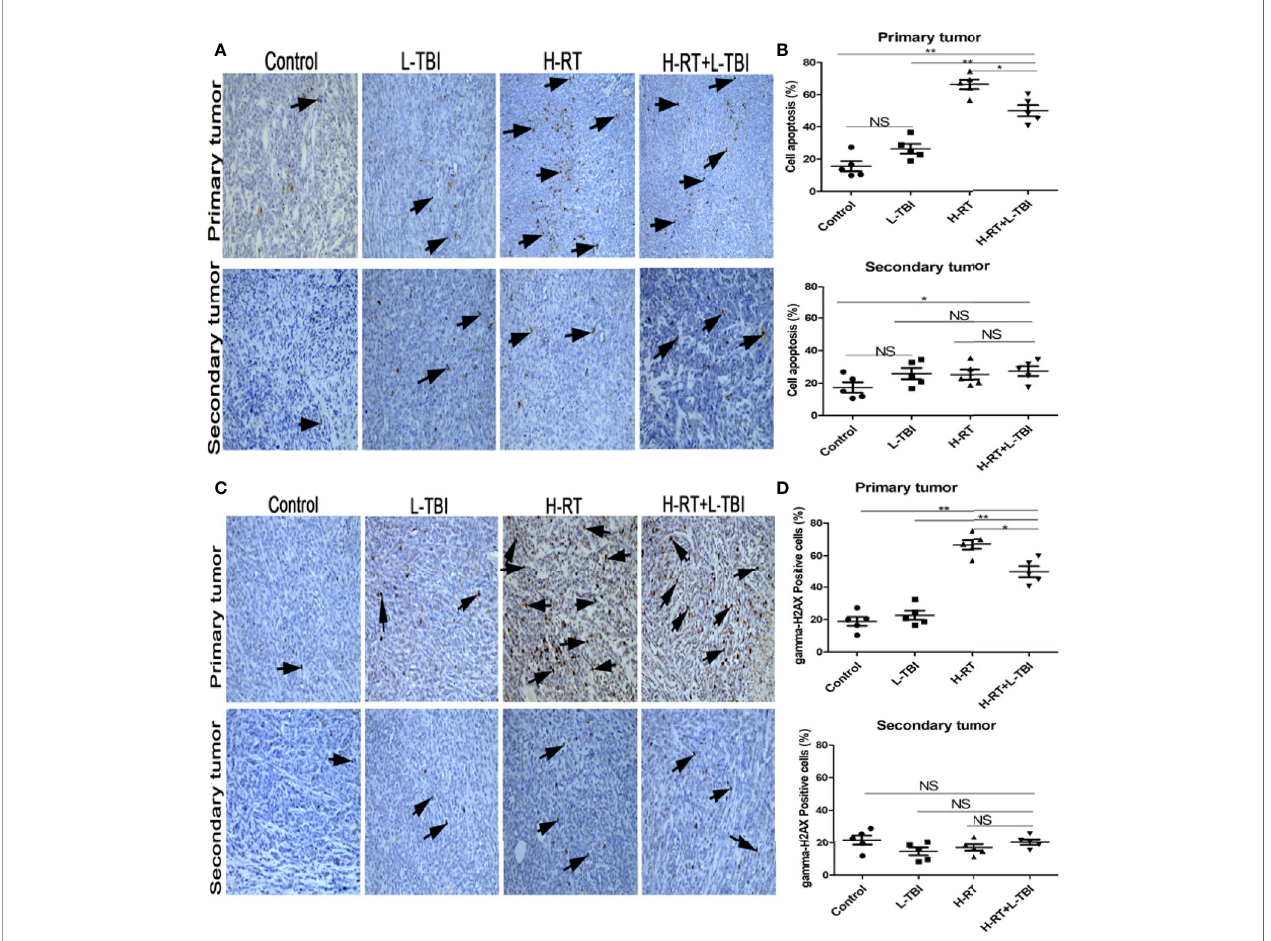
FIGURE 3 | Effect of combination H-RT and L-TBI therapy on apoptosis in 4T1 tumor bearing tissues. (A) Comparison of representative TUNEL IHC-stained in different treatment groups. (B) Percentage of TUNEL positive cells in the primary and secondary tumor. (C) Representative gamma-H2AX IHC staining image in different treatment groups. (D) Percentage of gamma H2AX positive cells in the primary and secondary tumor. The arrows point to the TUNEL and gamma-H2AX positive cells in the tumor tissue (original magni fi cation ×200). Data are expressed as mean ± SE of 5 mice/group. (*P < 0.05, **P < 0.01, and N, not signi fi